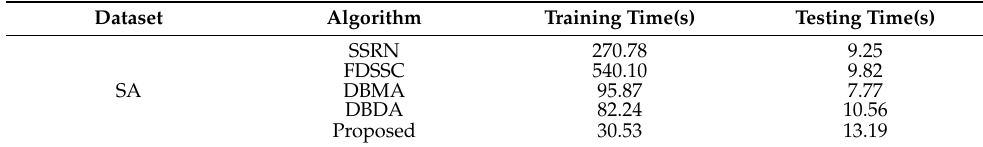
Table 13. Training and testing time consumption for the SA dataset.